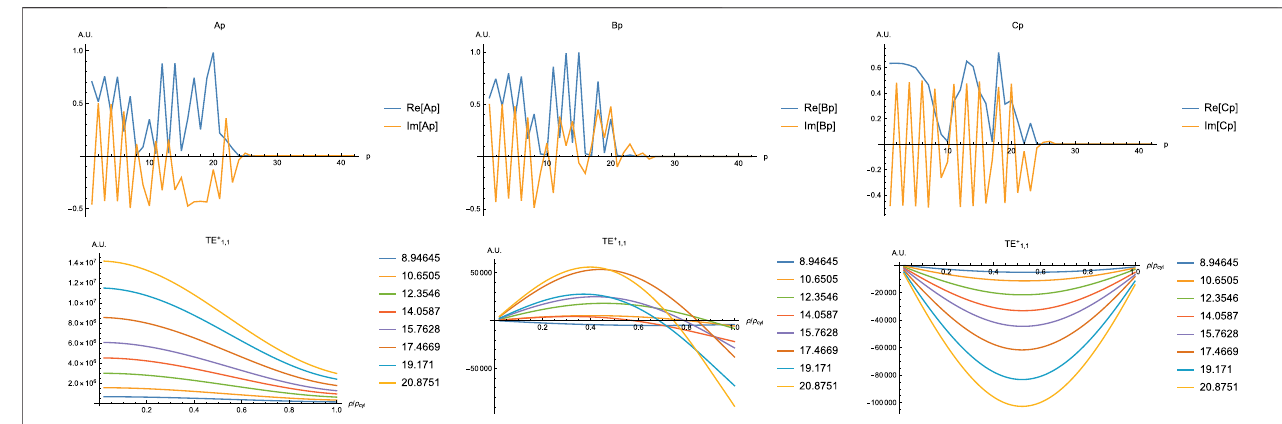
FIGURE 6 | At the top the coef fi cients for x (cid:1) 20.8751 (for a particle of 3.5 µm and a refractive index of 3. At bottom the forces (from left right F z , F ρ and F ϕ ) as function of the size parameter (on the legend at right), from the lower one (particle of 1.5 µm) to the biggest one (particle of radius 3.5 µm). We changed the radius of the waveguide to 20 µm to allow for larger values of x